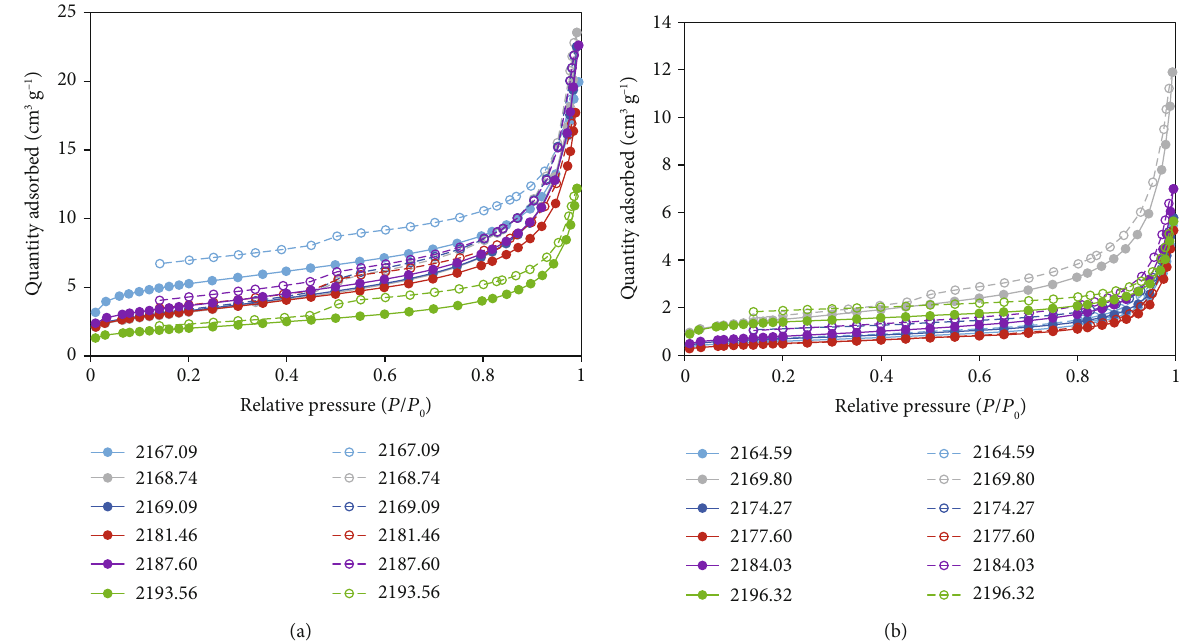
Figure 6: Isotherms of nitrogen adsorption and desorption for (a) shale and (b) limestone samples with di ff erent depths.